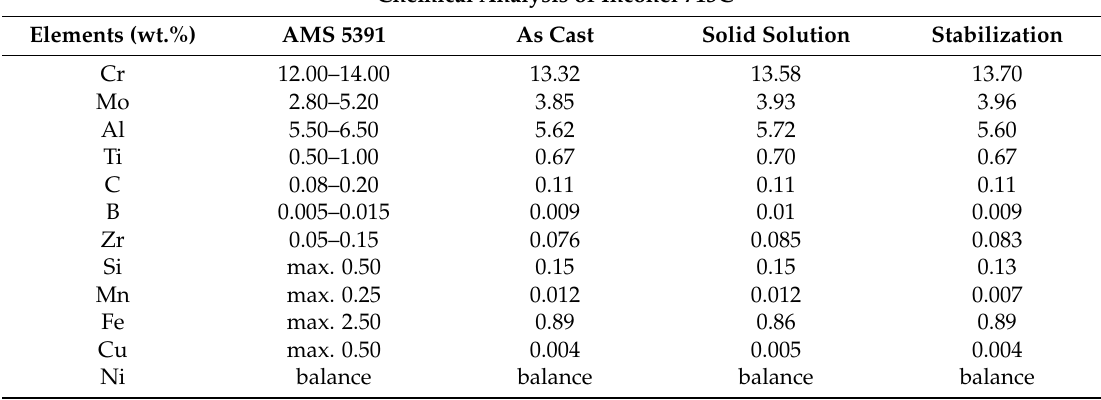
Table 1. Results of the chemical analyze of the Inconel 713C samples compared to the international standard AMS 5391.